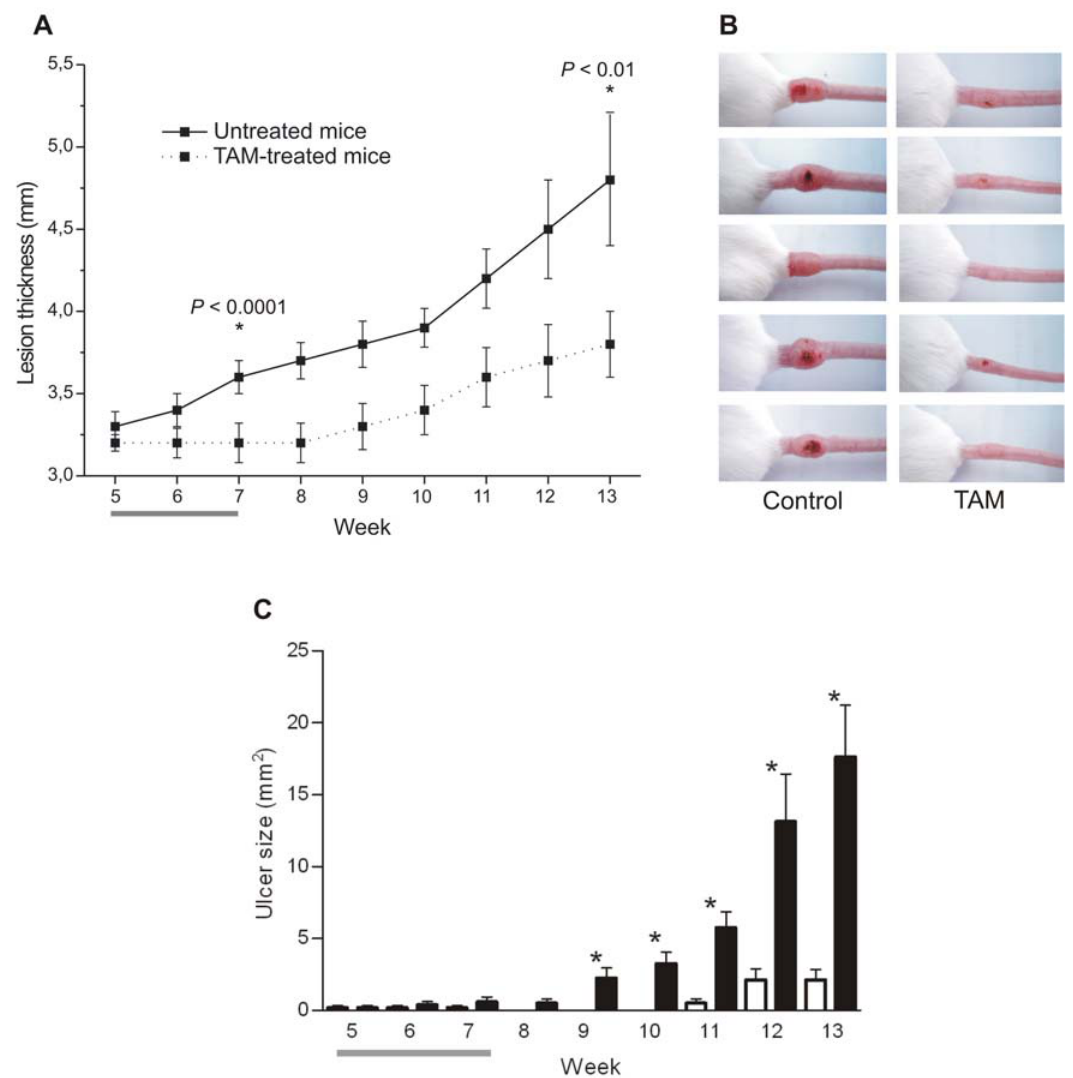
Figure 1. Follow up of L.amazonensis infection in BALB/c mice treated with tamoxifen (TAM). A: Progression of lesion thickness (mean 6 SD) in untreated (solid line) or TAM-treated (dotted line) mice. B: Macroscopical evaluation of lesions in untreated (left column) and TAM- treated mice (right column) at week 13 post-infection. C: Mean and SEM of ulcer size recorded from untreated (black bars) and TAM-treated animals (white bars). * P , 0.005. Data represents one of three independent experiments. A and C: Horizontal grey bars indicate period of TAM administration (n=10 per group from week 5 to 7 or n=8 per group after week 7).